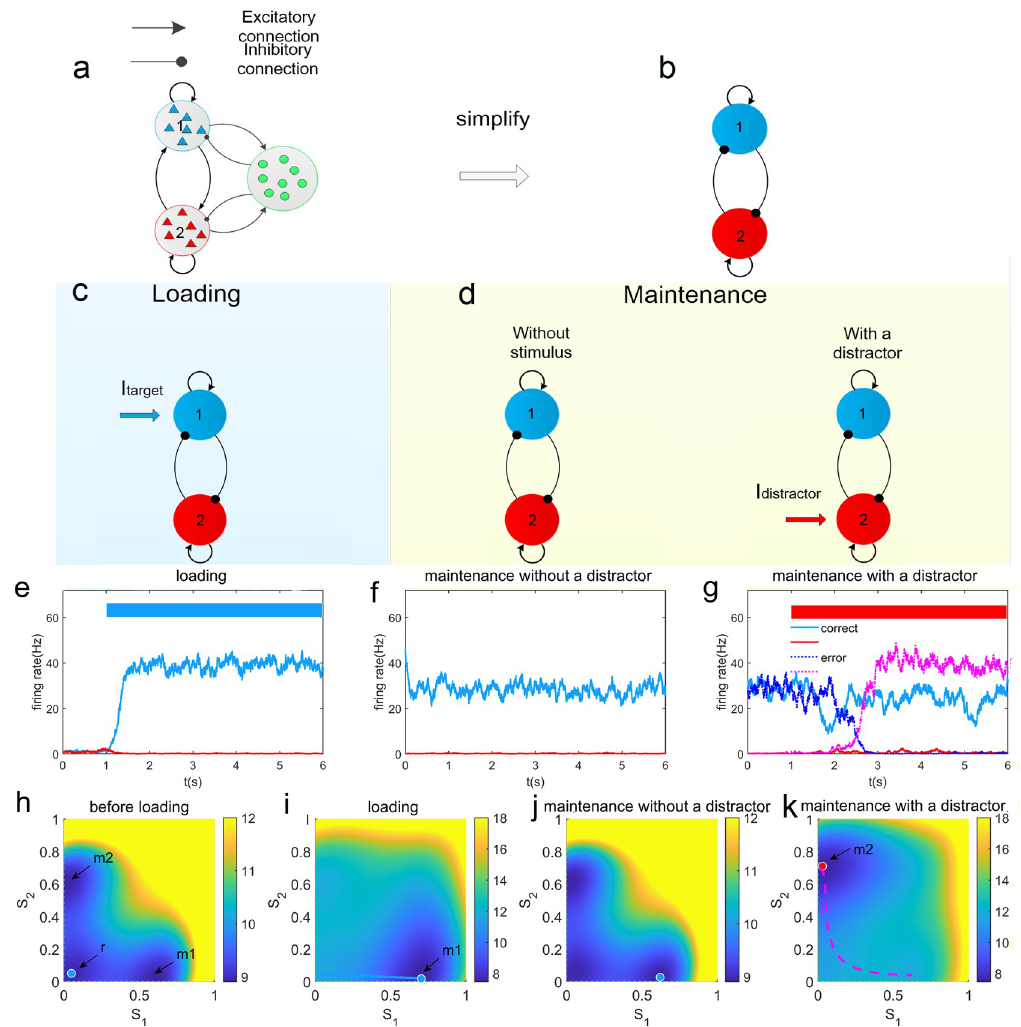
Fig 1. The schematic diagram of the circuit model for working memory. (a)The model is comprised of two selective, excitatory populations, labeled 1 and 2. Each excitatory population is recurrently connected and inhibit each other through a common pool of inhibitory interneurons. (b)The circuit model can be simplified through a mean field approach and the linearization of the inhibition. The effective inhibition from the pool of interneurons can be implicitly represented by the inhibitory connections between the excitatory populations. (c-d)The schematic diagrams for the WM during different phases in a WM task. During the loading phase, a target stimulus is presented. During the maintenance phase, this target should be held in WM against random fluctuations and distractors after the stimulus offset. (e-g)Neural activities of single trails during different phases. The colored bars mark the presentation of the stimulus input to the population 1(blue) and 2 (red), as the target and distractor stimulus, respectively. The blue and red lines represent the activities of population 1 and population 2, respectively. (e) Before the stimulus onset, the system stays at the resting state with both populations 1 and 2 at low activity. A target stimulus can quickly induce a stimulus-selective, high activity state. (f)This stimulus-selective state can be maintained in the absence of the target stimulus. (g)Correct and error trails in the presentation of a distractor stimulus. (h-k) The corresponding potential landscapes in the ( S 1, S 2) state space during different phases. The dimensionless quantities S 1 and S 2 are average synaptic gating variables of the two selective populations, which can represent the mean population activities. The label r indicates the attractor representing the resting state. The attractors representing the target-related and distractor-related memory state are labeled with m 1 and m 2, respectively. After the onset of the target stimulus, the target-related memory state becomes dominated. The blue solid line indicates the transition from the resting state to the target-related memory state. (k)During the maintenance phase, the underlying potential landscape is changed by the presentation of a distractor stimulus, which may induce the transition to the distractor-related attractor(pink dashed line). In this figure, we used the baseline values of circuit connection strengths as J + = 0.30 nA , J − = 0.05 nA